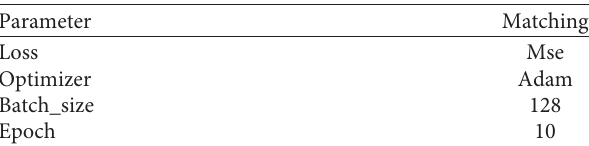
Table 4: Training parameters of trend series and residual series of prediction